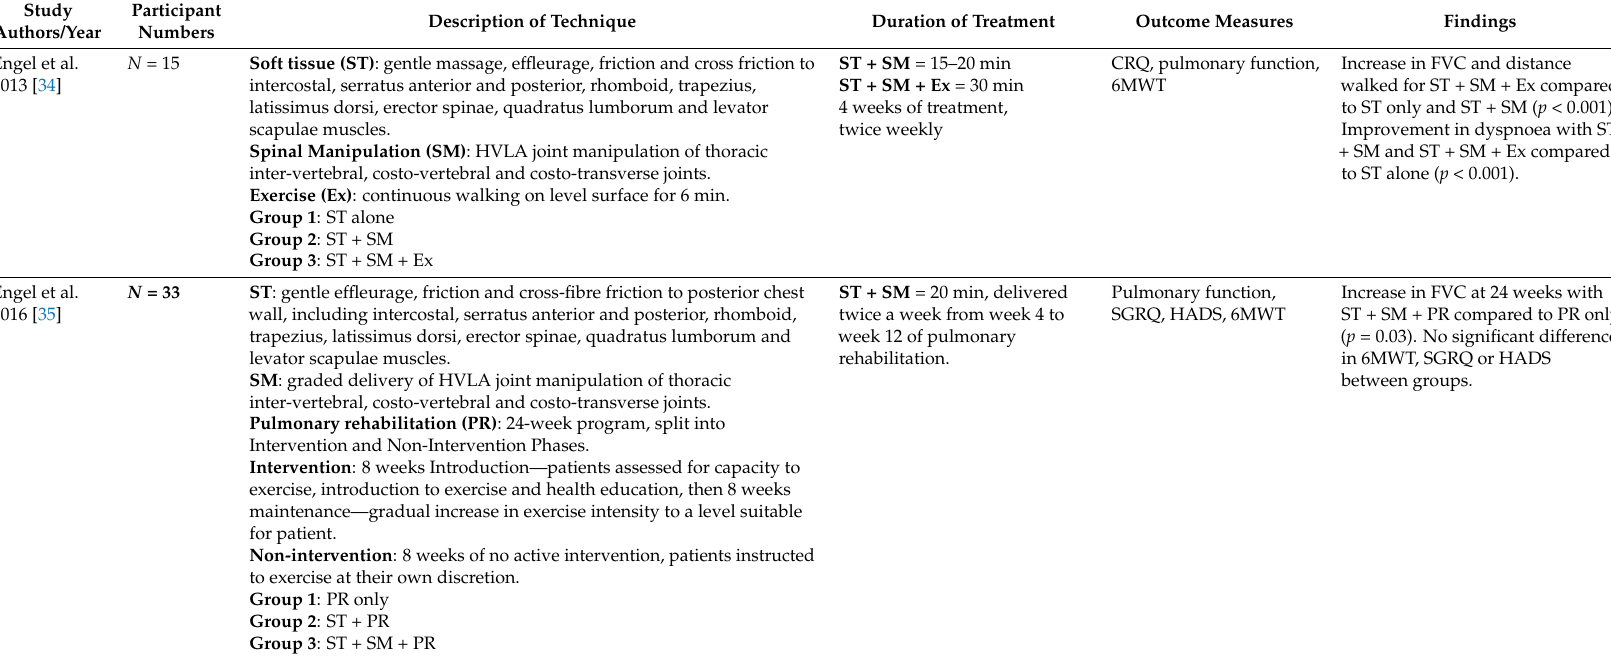
Table 1. Techniques and prescription of manual therapy treatments in